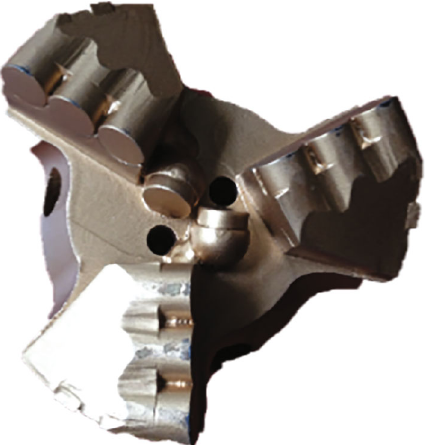
Figure 8: Schematic diagram of diamond compact drill bit.